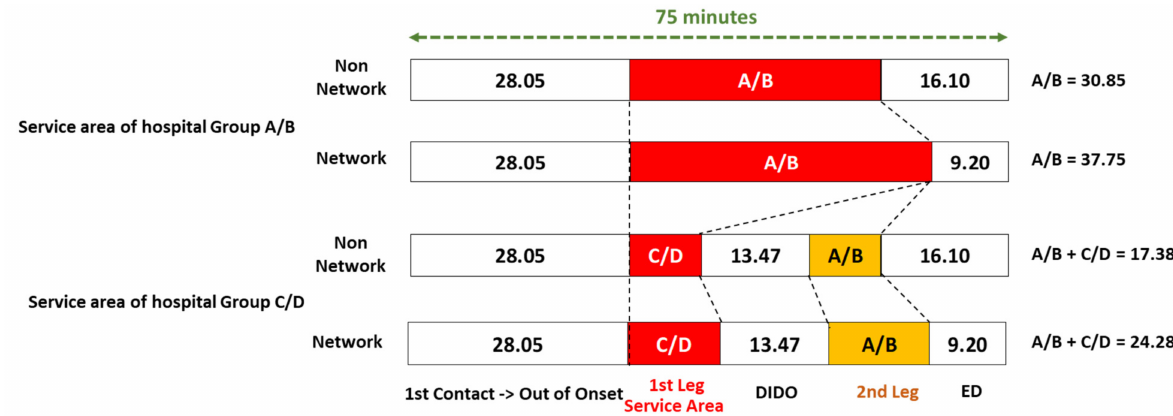
Figure 8. Time spent in each node and the remaining time for each service